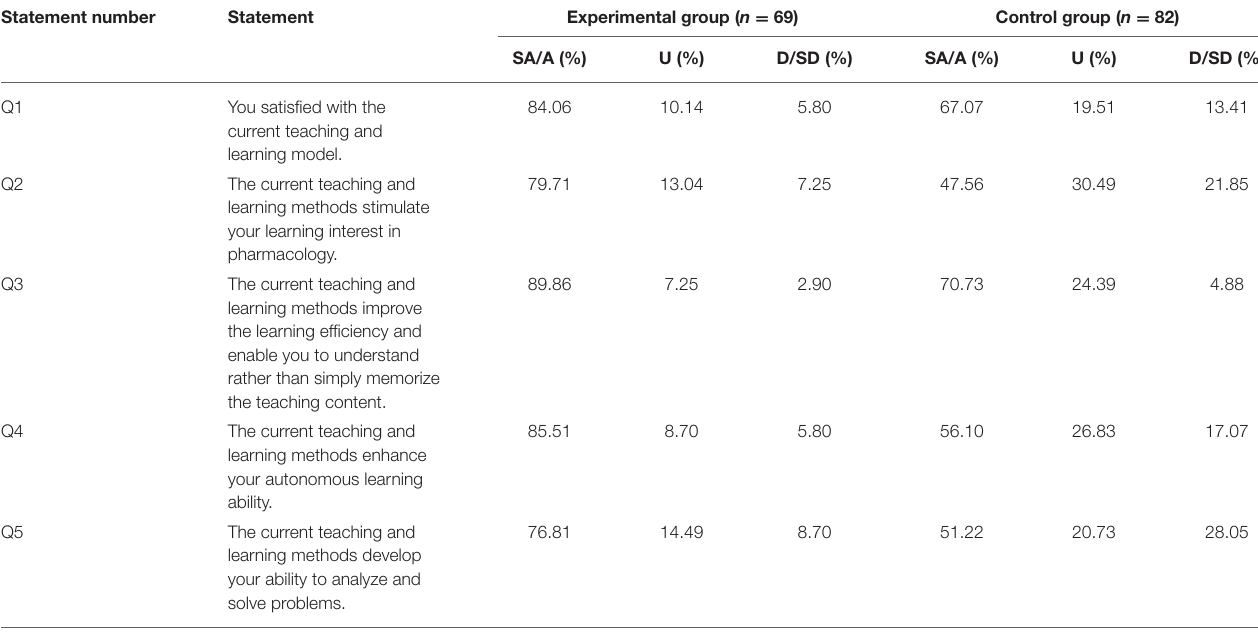
TABLE 3 | Responses to questionnaire from students regarding the teaching and learning effects. Statement number